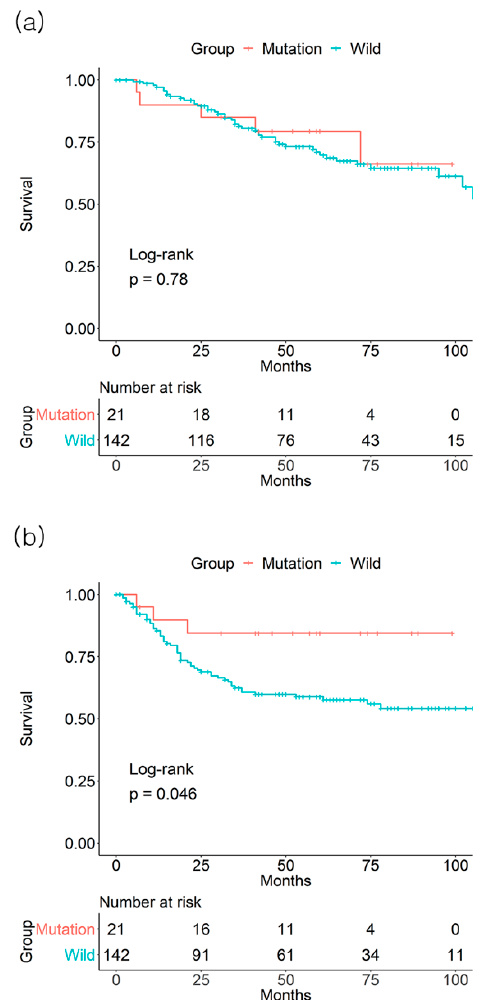
Figure 3. Effect of BRAF mutation on ( a ) 3-year overall survival and ( b ) 3-year disease-free survival from the GSE39582 database of colorectal cancer stage III patients.